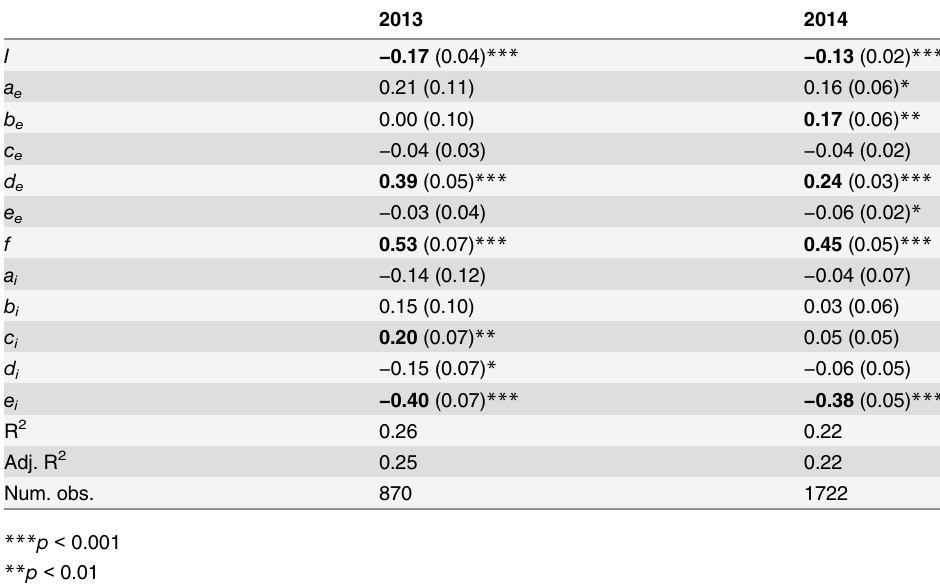
Table 1. Regression results of TT model for TT-2013 and